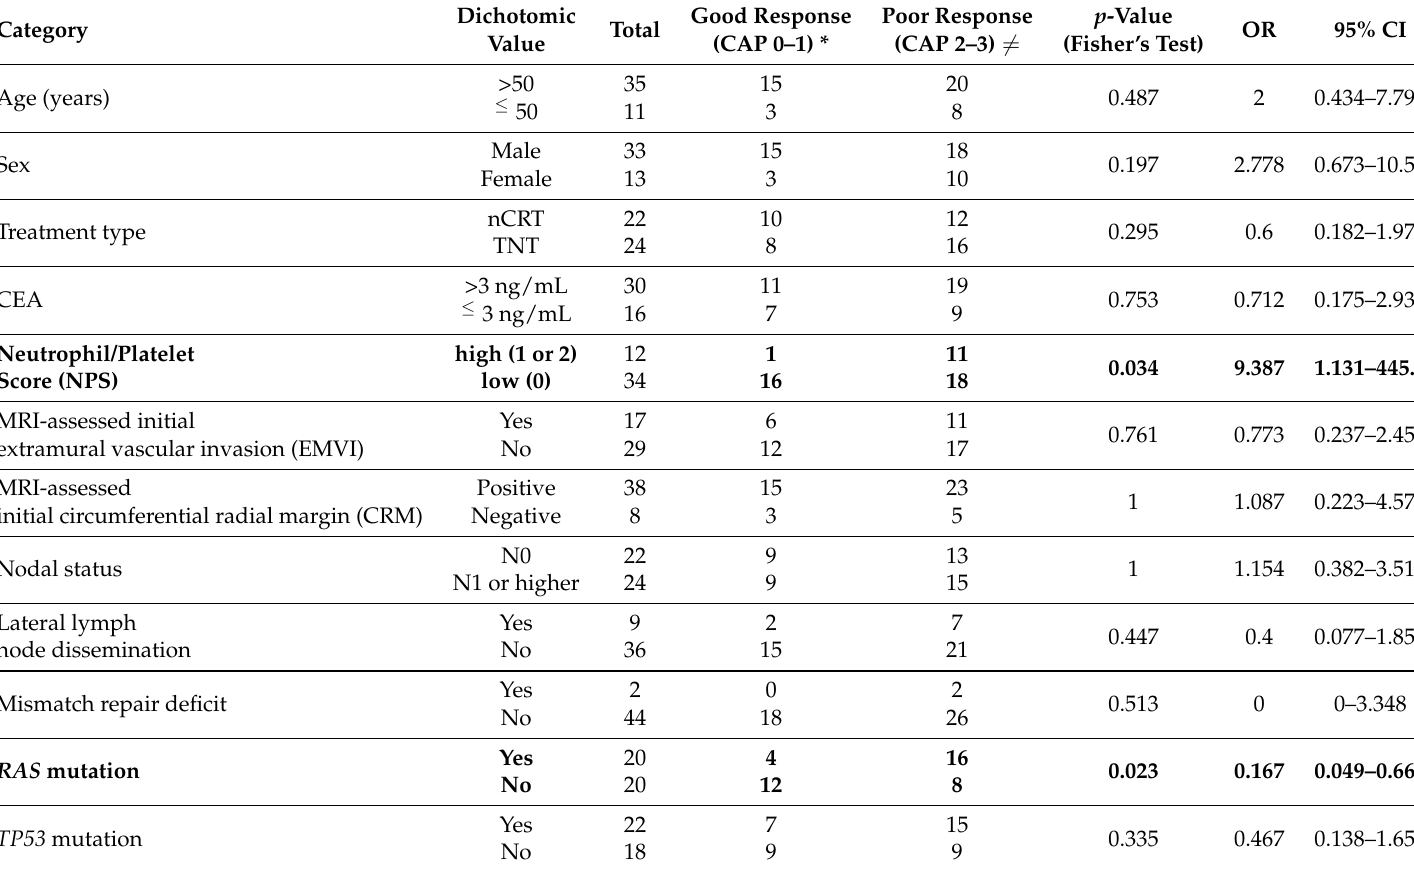
Table 2. Evaluation of clinical and molecular predictive factors in the LARC cohort using Consensus Response (CR) as a measure of response to